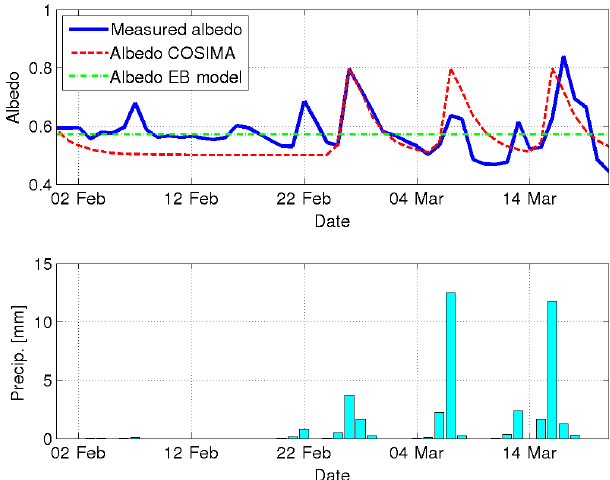
dall Glacier is only 4 W m − 2 . Another clear trend form north